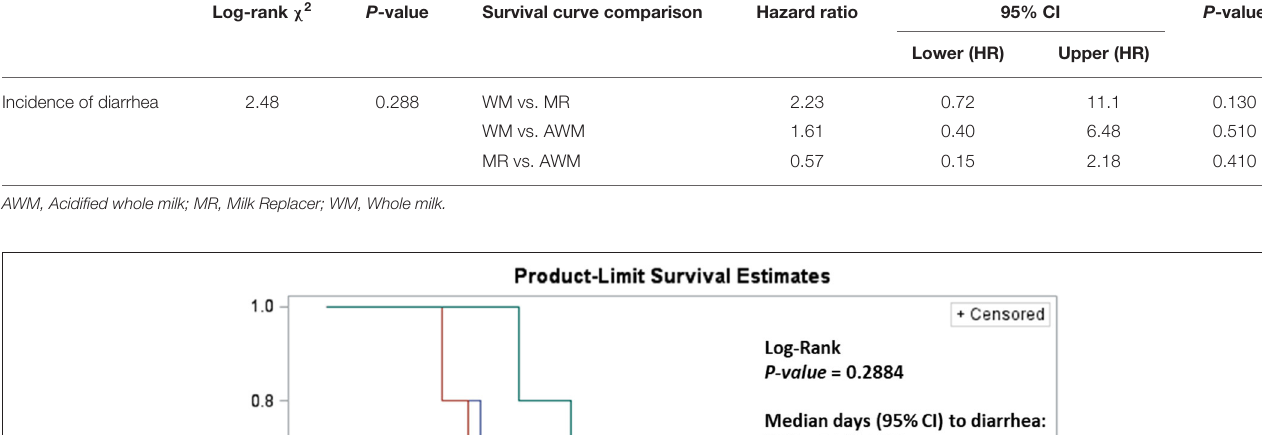
TABLE 3 | Log-rank (Mantel-Cox) and Mantel Haenszel hazard ratio comparison between the cumulative incidence of diarrhea from birth to weaning in calves fed with different liquid diets. Log-rank χ 2 P -value Survival curve comparison